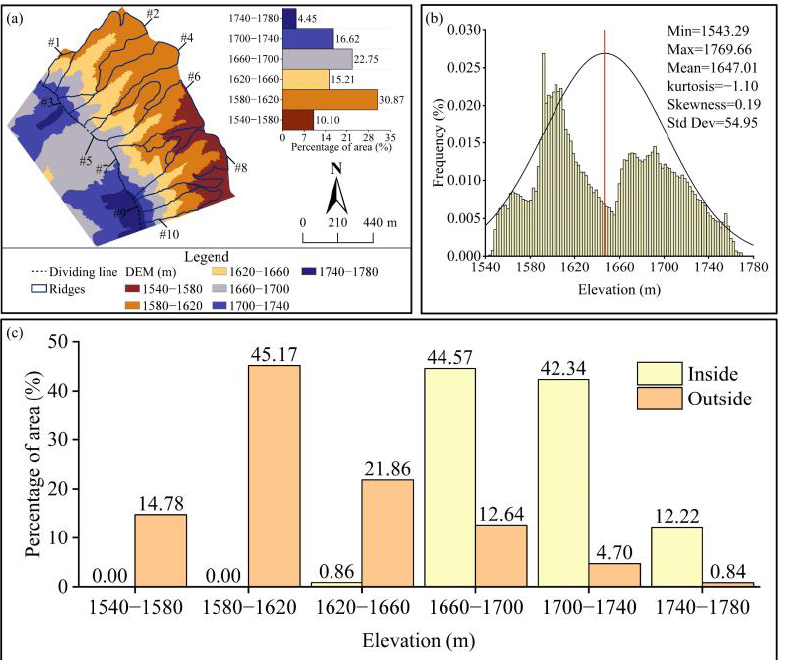
Figure 6. ( a ) The DEM reclassification results, ( b ) the elevation frequency statistics, and ( c ) the statistical results of the proportion of DEM areas inside and outside the pit rim structure.